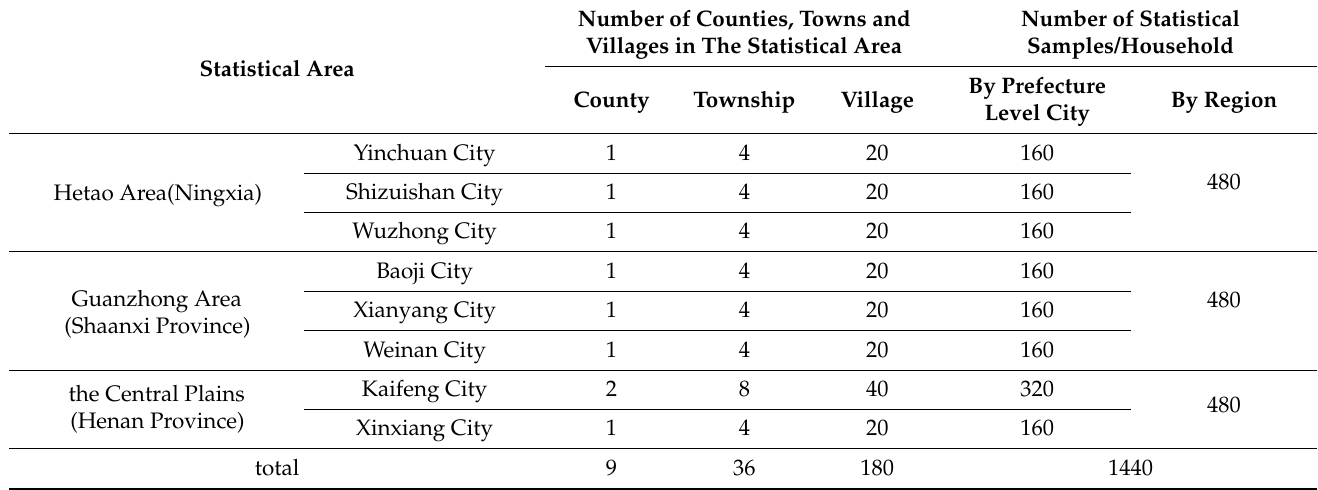
Table A1. Statistical range and sample size of the